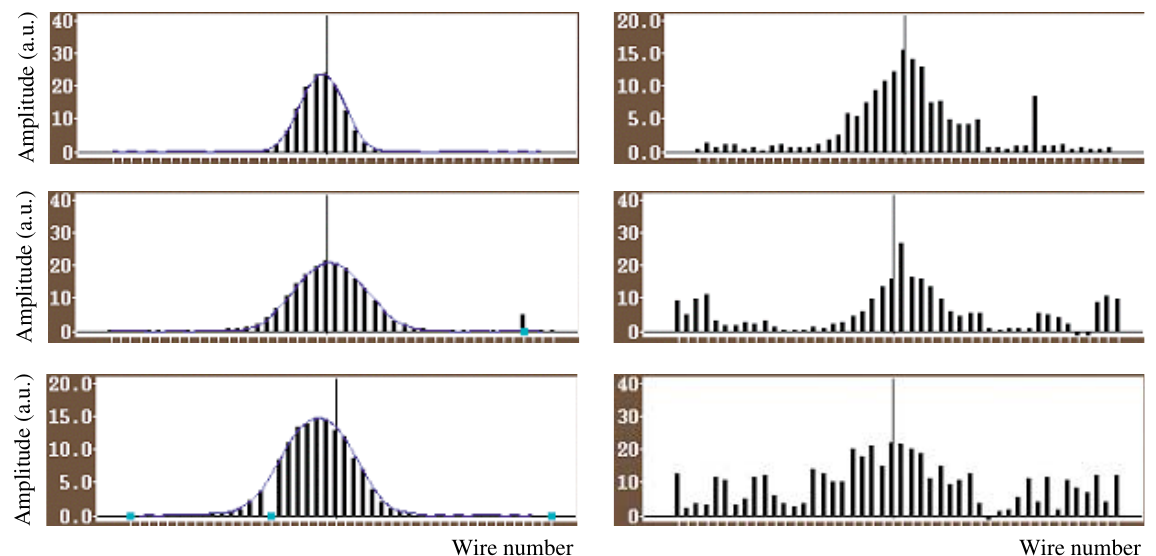
FIG. 3. (Color) Transverse horizontal beam profiles measured with secondary emission monitors at three different locations in the TT2 transfer line. The measurements performed without bunch rotation are shown on the left, while the profiles on the right are obtained with the final bunch rotation active. The wire spacing is 0.5 mm for all the monitors except the central one where the spacing is 0.35